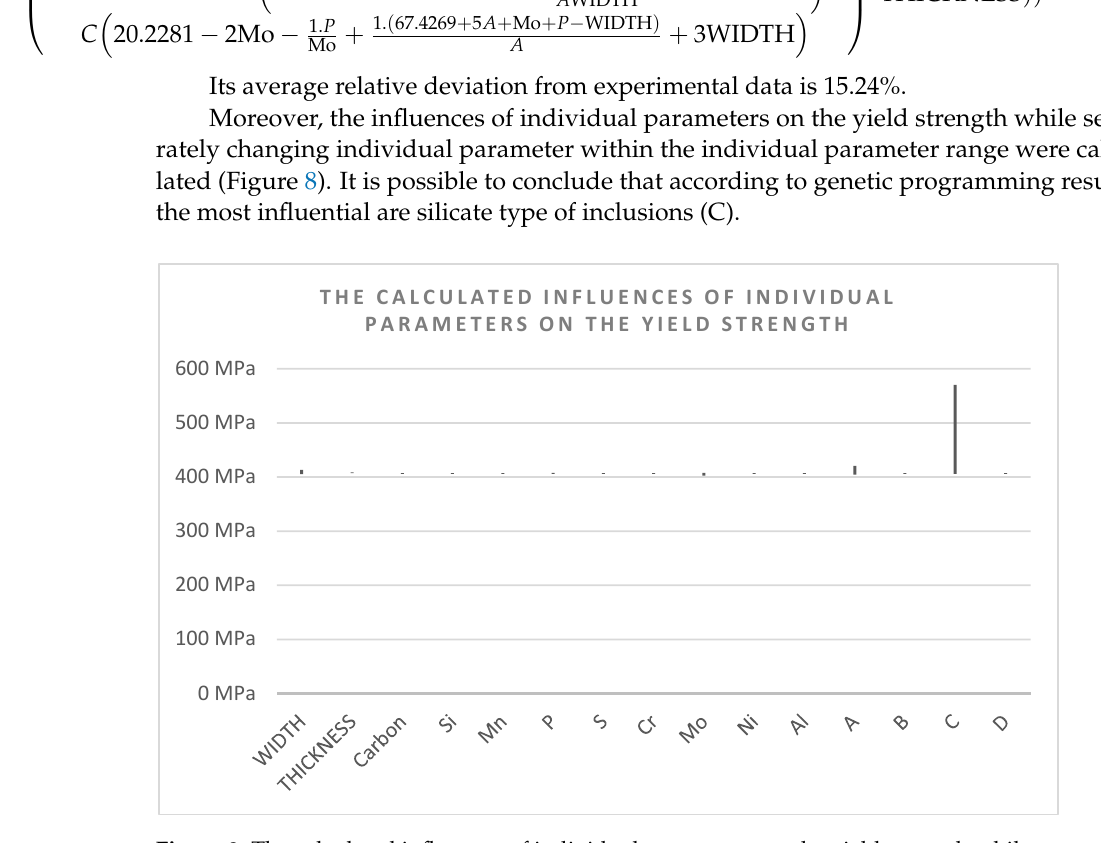
Figure 8. The calculated influences of individual parameters on the yield strength while separately changing individual parameter within the individual parameter range.